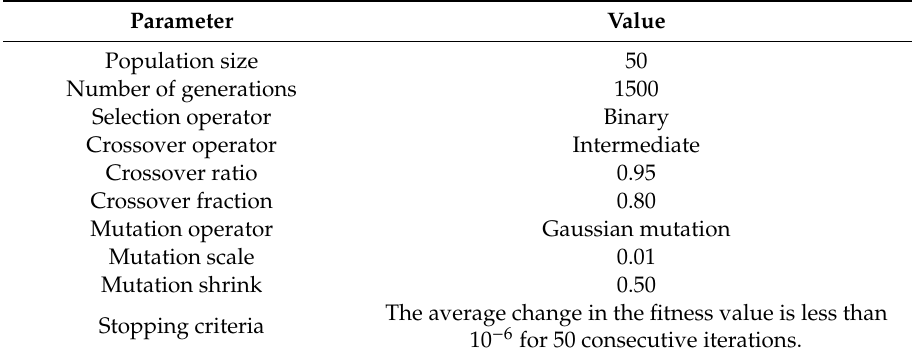
Table 1. Simulation Parameters of the GA.